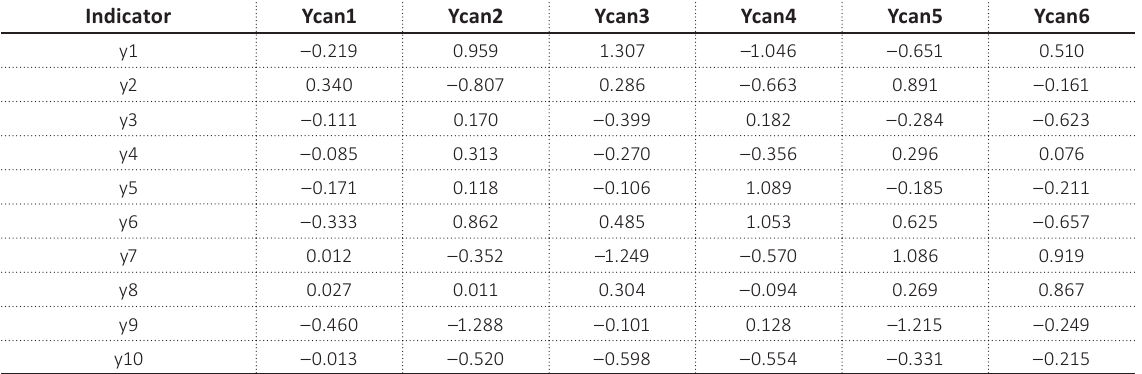
Table 5. Standardized canonical coefficients for labor market efficiency indicators